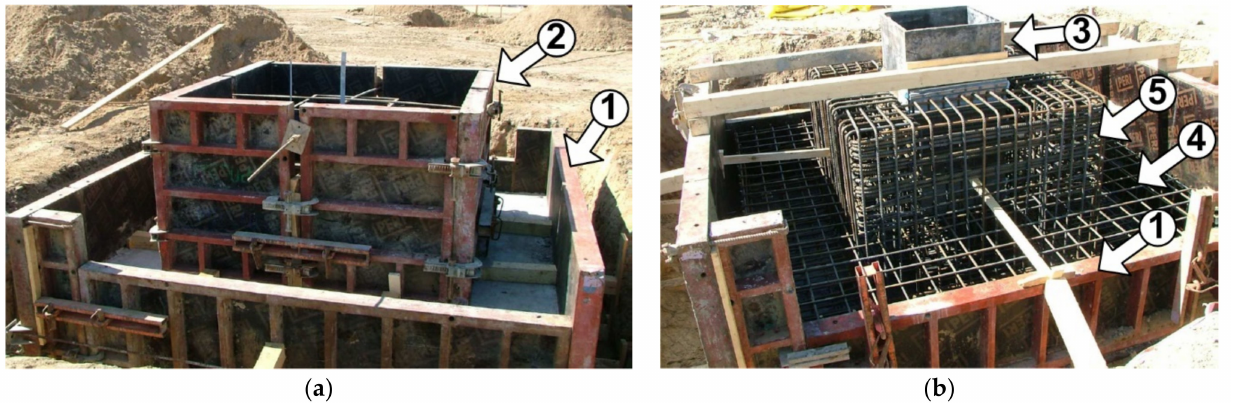
Figure 11. View of PF formworks prepared: ( a ) in two stages, ( b ) in one stage; 1—formwork of the lower part of the foundation, 2—formwork of the pocket, 3—insert forming the inner surface of the pocket, 4—reinforcement of the lower part of PF, 5—reinforcement of the